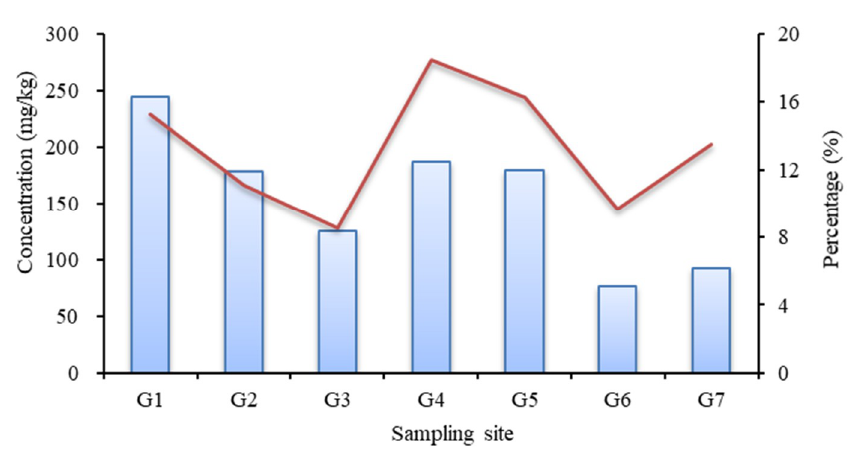
Figure 6. The concentration of potential bioavailable phosphorus (blue bars) and its proportion (red line) relative to TP in the Zipingpu Reservoir.